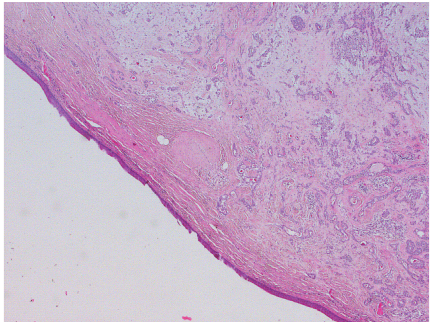
Figure 4: Entire section of the lesion (hematoxylin-eosin